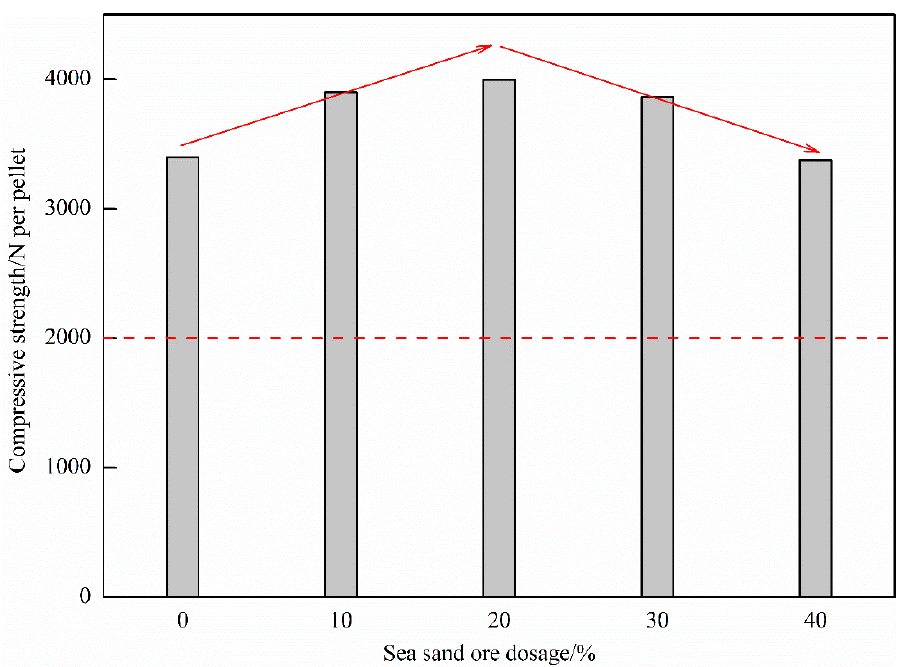
Figure 5. Compressive strength of oxidized pellets with different the dosage of sea sand ore.